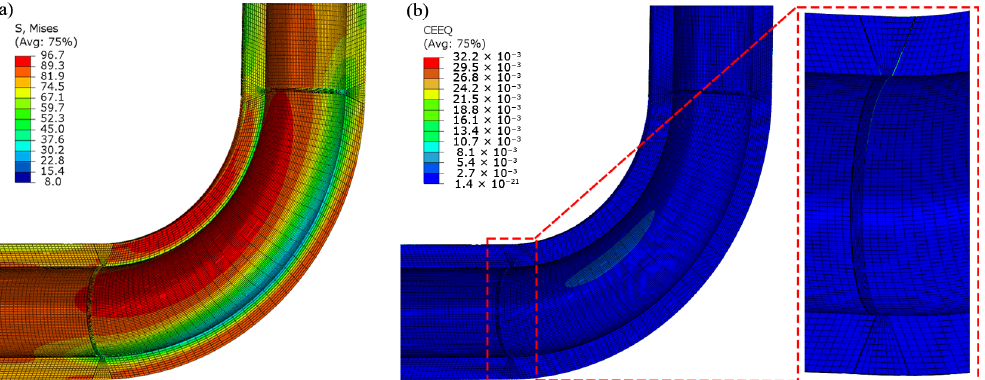
Figure 7. Equivalent stress ( a ) and equivalent creep strain ( b ) of pipe to elbow welded joint after creep proceeded for 5000 h.